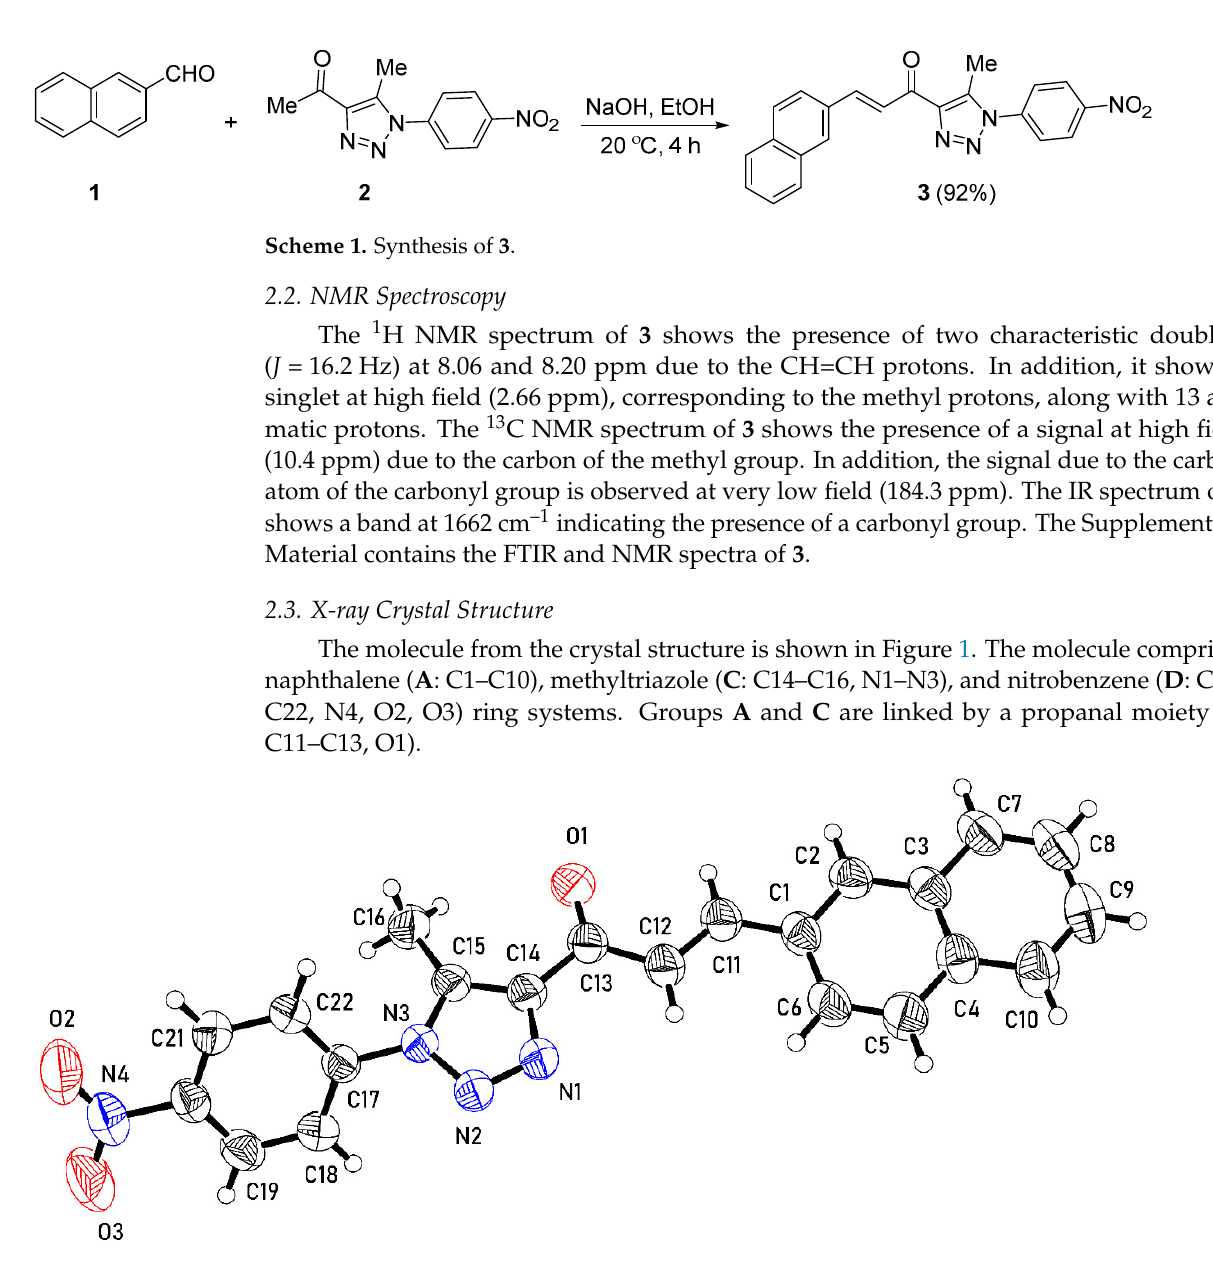
Figure 1. An ortep representation of the molecule of 3 showing 50% probability atomic displace- ment ellipsoids.